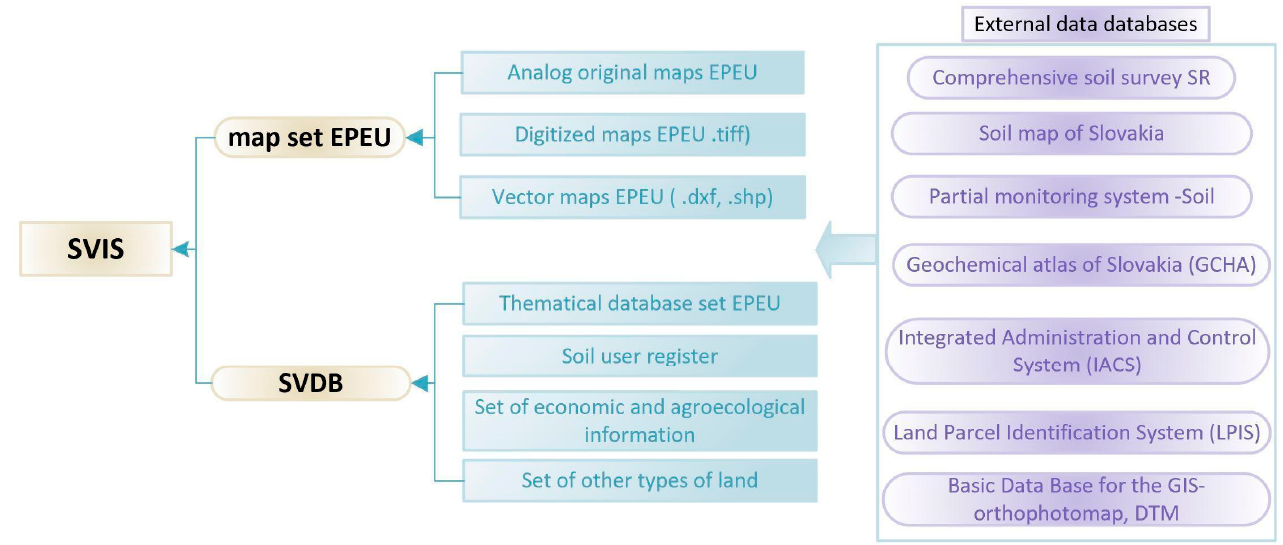
Figure 2. Soil value information system structure.